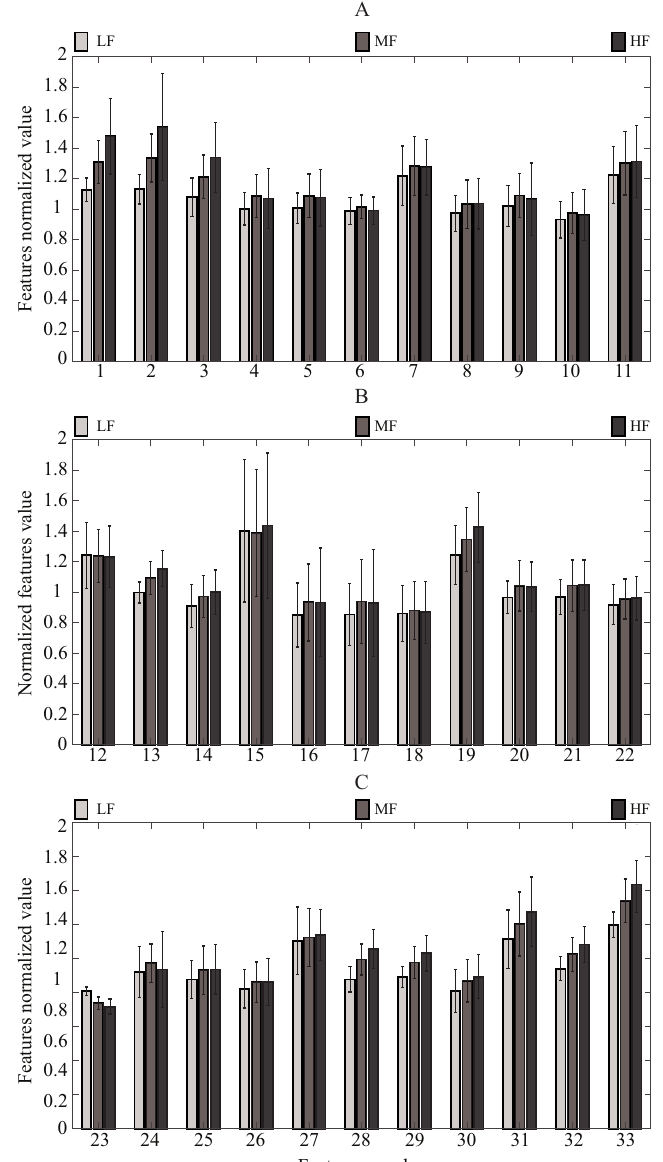
Figure 12. Mean and standard deviation values of each feature, according to the 3 fatigue conditions. ( A ) corresponds to the features values between 1 to 11; ( B ) corresponds to the features values among 12 to 22; ( C ) corresponds to the features values between 23 to